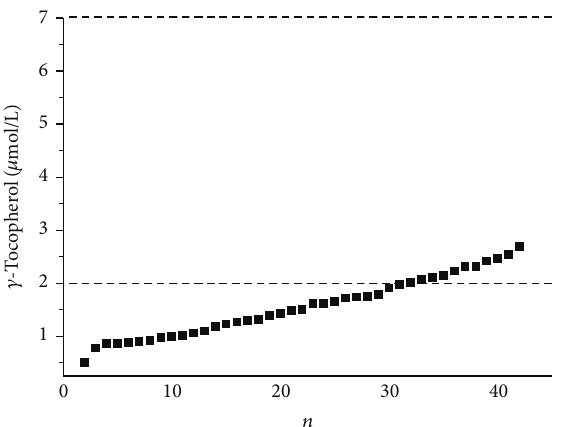
Figure 1: Serum 𝛾 -tocopherol levels in multiple sclerosis patients ( 𝑛 = 42 ) compared to reference range (2–7 𝜇 mol/L).